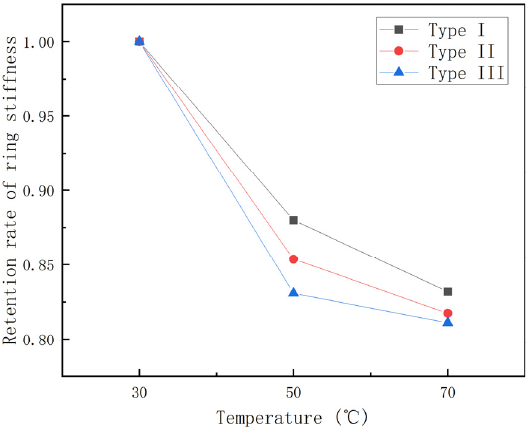
Figure 5. Ring stiffness retention—temperature curve.